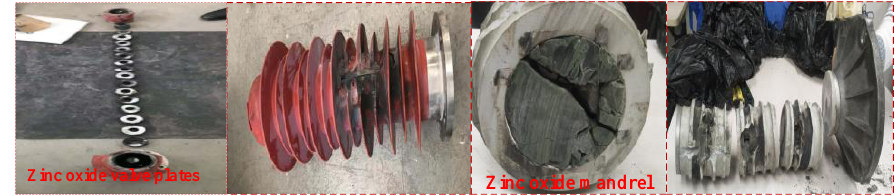
Figure 1. Arrestor explosion under high harmonic action.